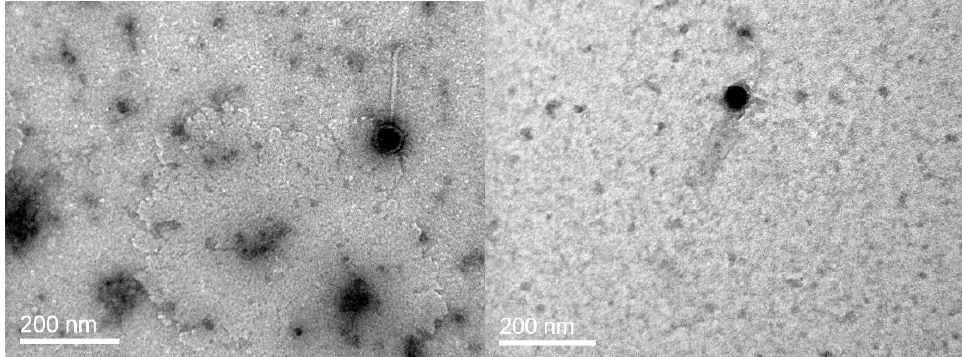
Figure 1. Transmission electron microscopy micrographs of bacteriophages: φ VaK ( left ); and pVa-7 ( right ) classifying them to Siphoviridae family.